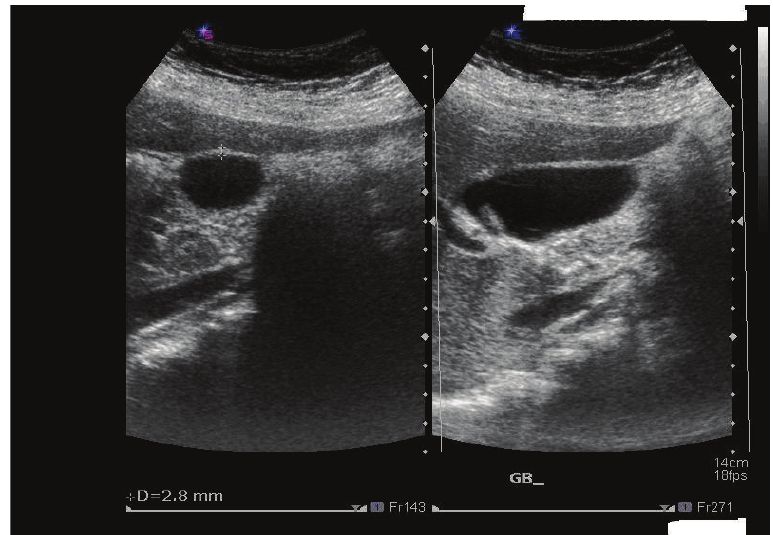
Figure 2: Abdominal U/S showing normal thickness of gallbladder